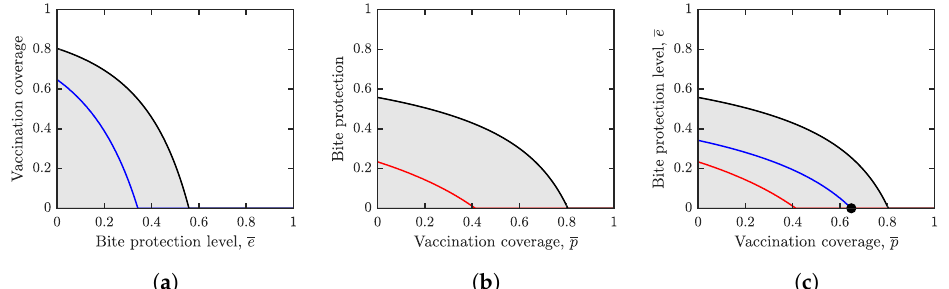
Figure 3. Herd immunity values (black) and Nash equilibria values (blue in ( a ), red in ( b ) and the black dot in ( c )). Unless varied, the parameters are as specified in Table 1. The white regions represent a parameter combination for which R < 1 and the outbreaks can be contained. The gray regions represent a parameter combination for which R > 1. ( a ) The optimal voluntary vaccination coverage, p NE , (blue) and the vaccination coverage needed for herd immunity, p HI (black), as they depend on e . Here we assume that e is fixed and individuals can only choose whether to vaccinate or not. Both p NE and p HI are decreasing functions of e and p NE < p HI . ( b ) The optimal voluntary bite protection level, e NE , (red) and the bite protection level needed to achieve herd immunity, e HI , (black) as they depend on p . Here we assume that individuals can only choose how much they want to prevent bites while the vaccination coverage p is fixed. Both e NE and e HI are decreasing functions of p and e NE < e HI . ( c ) Nash equilibrium of the general game (black dot) when individuals can choose vaccination and bite prevention. The Nash equilibrium is at the intersection of the curves from ( a , b